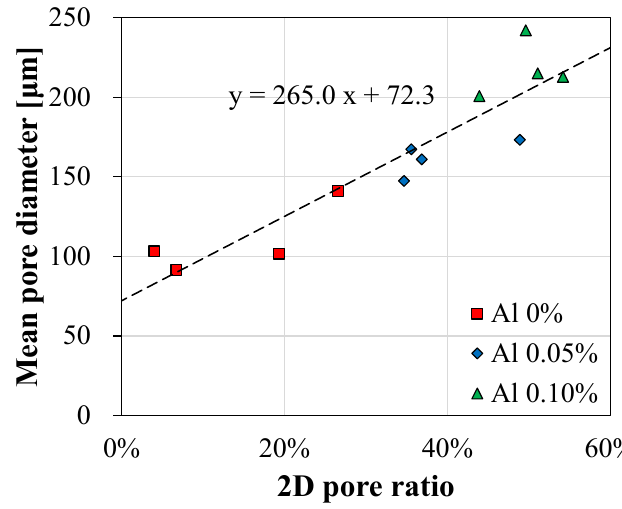
Figure 7. The relationship of the 2D pore ratio with the mean pore diameter obtained using the local thresholding image processing method.